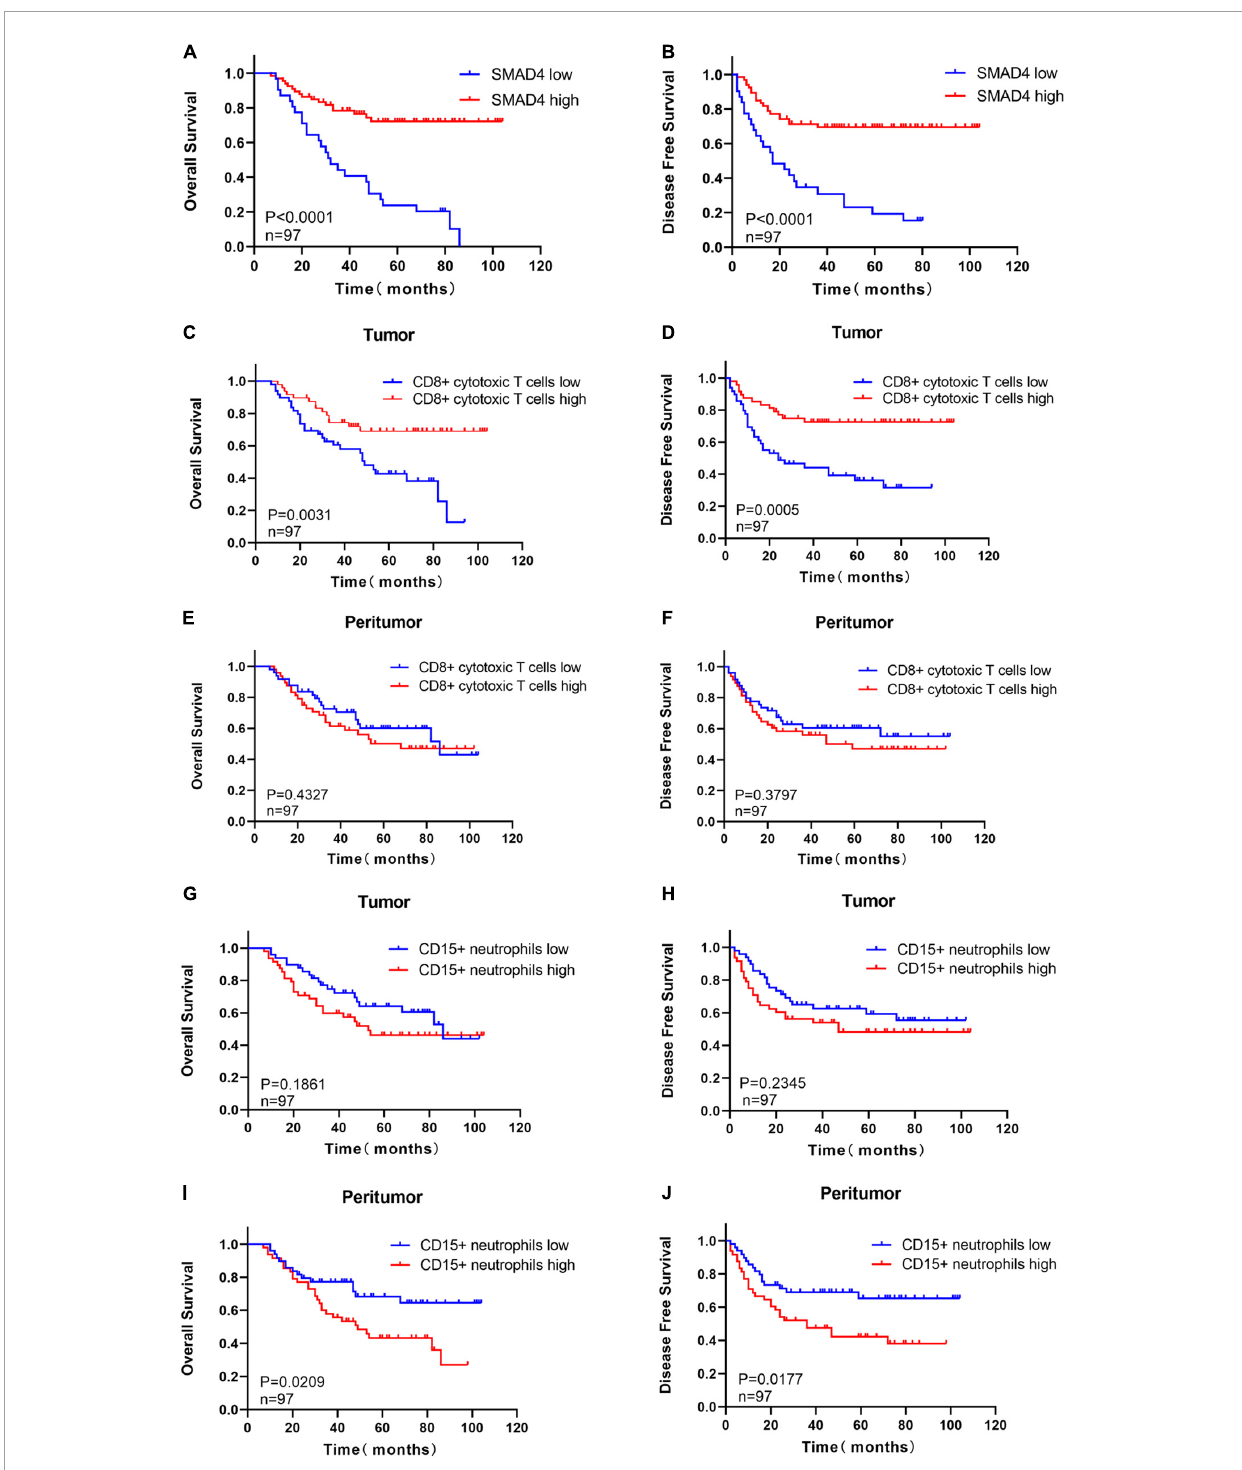
FIGURE2 Prognostic value of SMAD4, CD8 + cytotoxic T cells, and CD15 + neutrophils in HPC. High expression level of SMAD4 indicates longer OS (A) and DFS (B) . Prognostic value of intratumoral (C,D) or peritumoral (E,F) CD8 + cytotoxic T cells in HPC. The prognostic value of intratumoral (G,H) or peritumoral (I,J) CD15 + neutrophils in HPC. DFS, disease-free survival; HPC, hypopharyngeal carcinoma; OS, overall survival.